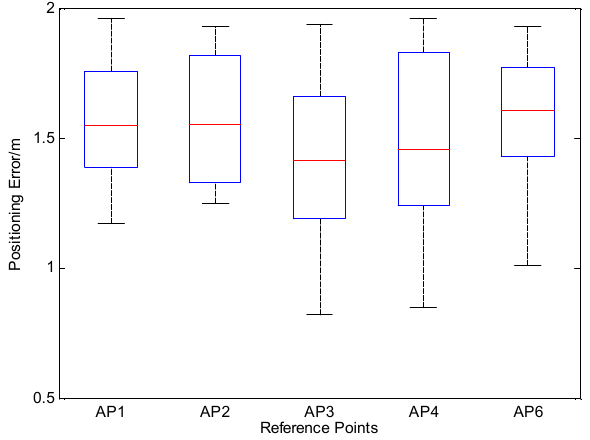
Figure 14. Positioning errors at each reference point.